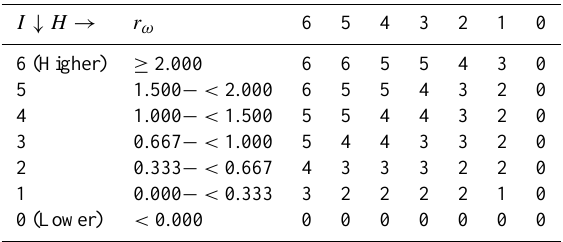
Table 4. Impact hazard indicator IH: combination of H and I , r ω is computed according to Eq.